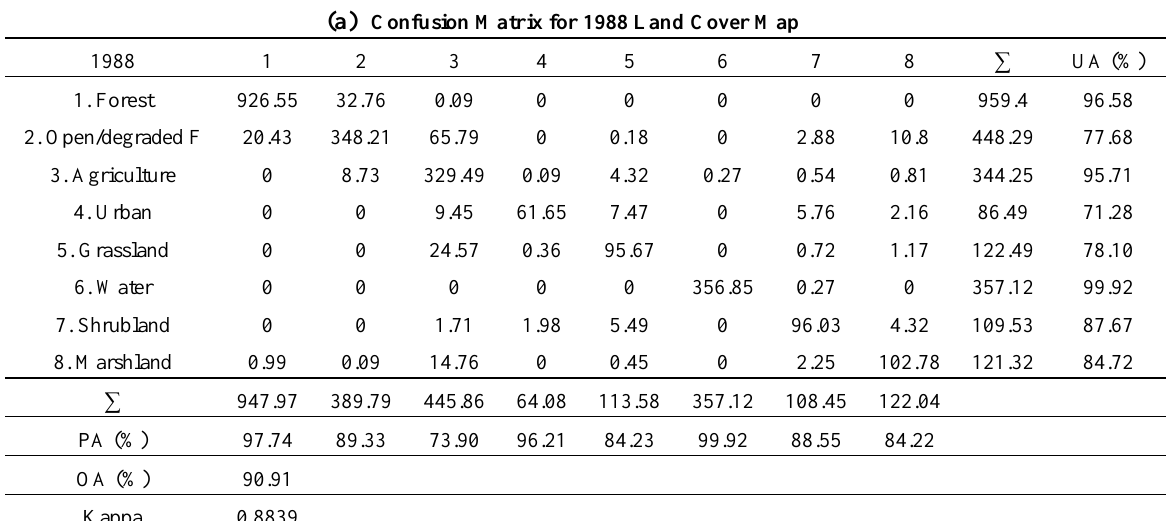
Table 4. Confusion matrices for land cover maps (in Hectares) for years 1988, 2001, and